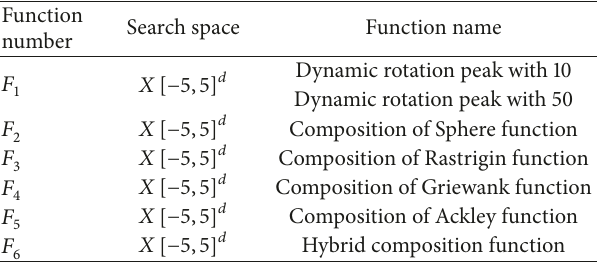
Table 1: Summary of the dynamic benchmark functions employed in the